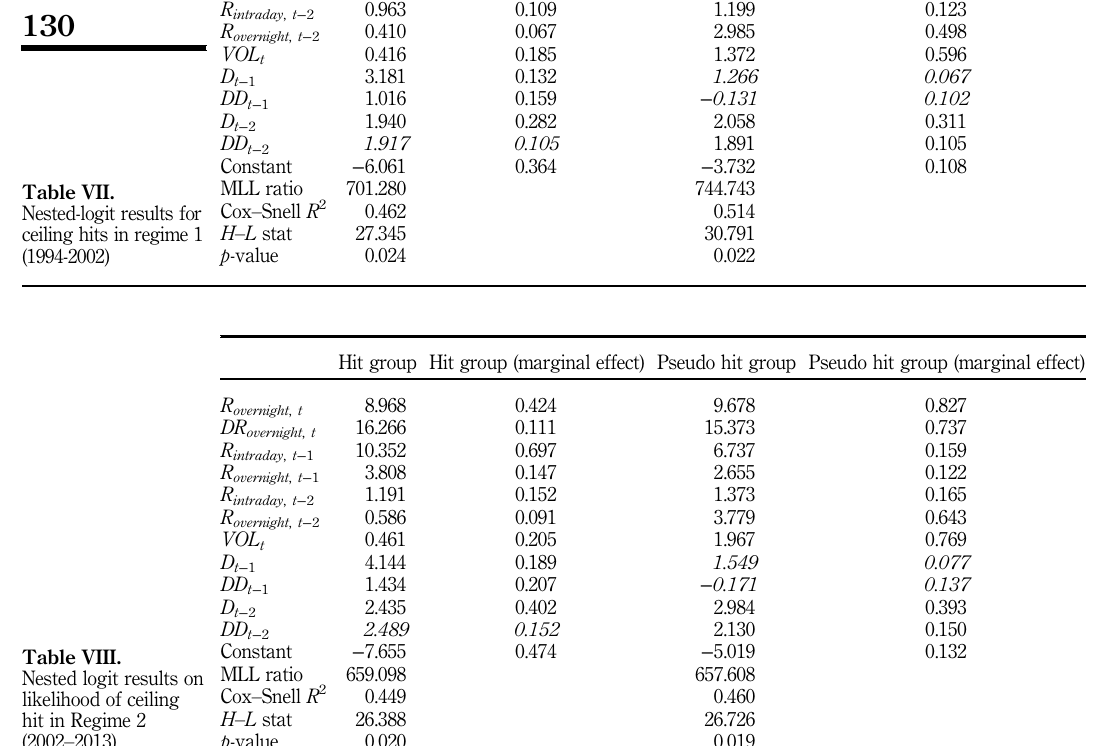
Table VIII. Nested logit results on likelihood of ceiling hit in Regime 2 (2002 – 2013)